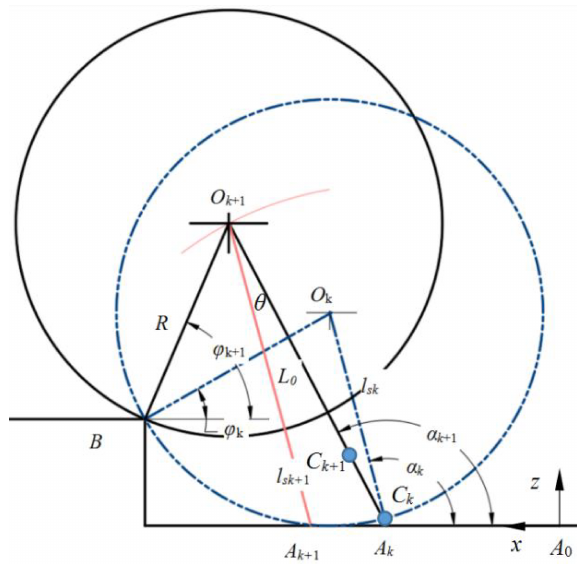
Figure 6. The legged overrun walking